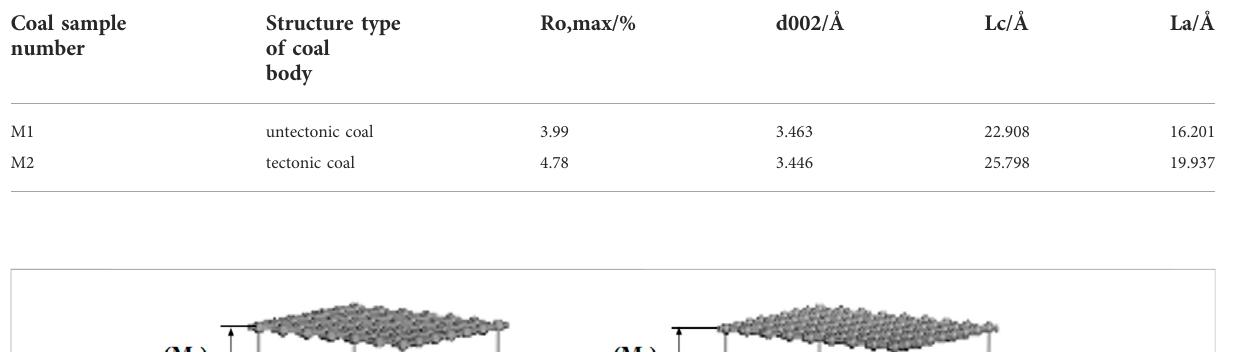
Frontiers in Earth